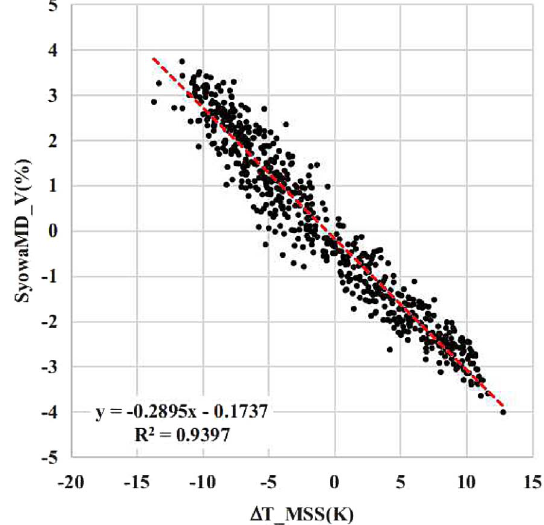
Fig. 9. A scatter plot between D T MSS and the pressure corrected daily mean count rate in Syowa MD vertical channel (SYO_MD_V). The derived regression coef fi cient ( a MSS ) is (cid:3) 0.289 ± 0.004 (%/K) and the correlation coef fi cient is 0.94.